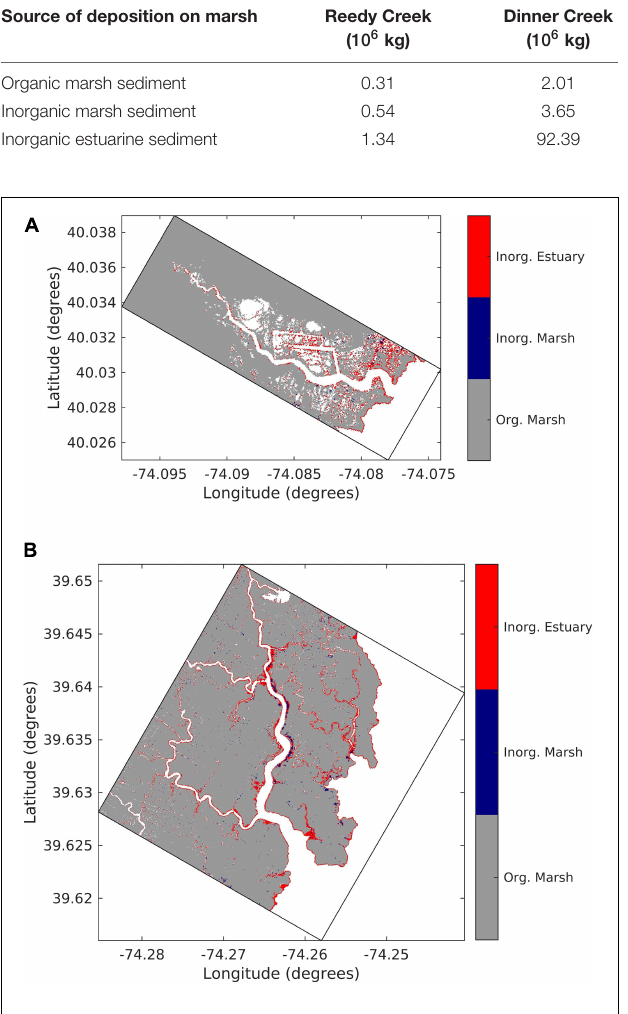
FIGURE 13 | Combined pattern of sediment deposition on marsh cells at the end of the simulation coded with different colors for dominant source of sediment (gray = organic marsh, blue = inorganic marsh, red = inorganic estuarine sediment) in (A) Reedy Creek domain and (B) Dinner Creek domain. Color coding corresponds to a particular source of sediment if its contribution exceeds 50% in that cell. For example, if a cell gets a deposition of organic marsh sediment greater than 50%, that cell is coded with a gray